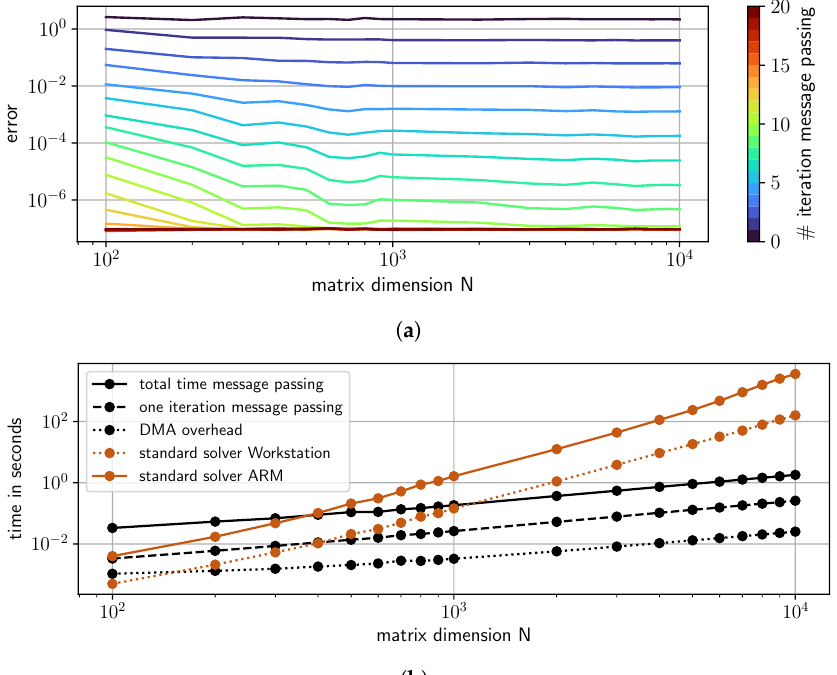
Figure 10. The plots compare the performance of our approach when solving the Random LESs on the Zynq UltraScale board to a standard solver (ones running on a workstation and ones running on-board on the ARM processing system). In ( a ), the error of our approximated solution after a certain number of Message Passing iterations is shown for different dimensions of the LES. In ( b ), the time of the standard solver is compared to the total time our Message Passing Algorithm requires to archive a solution better than 10 − 5 . In addition, the time of a single iteration is plotted as well as the DMA overhead.